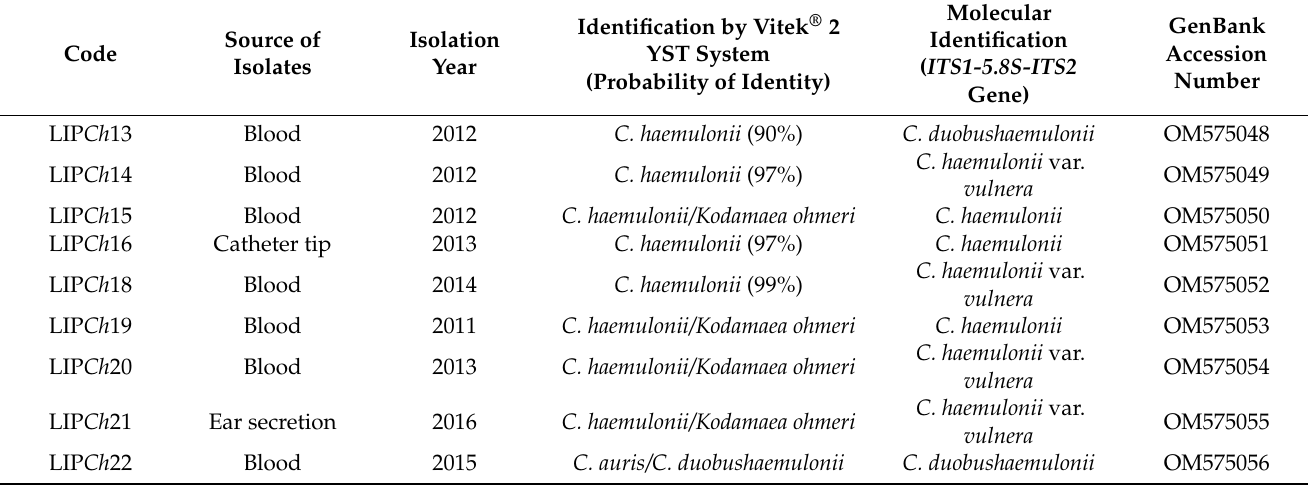
Table 1. Biochemical and molecular identification of the C. haemulonii species complex used in the present